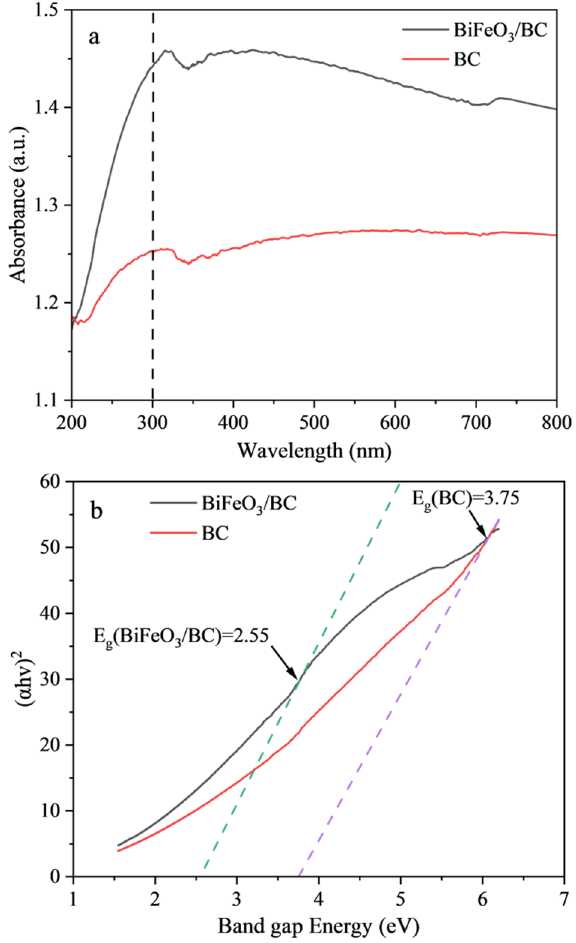
Figure 4. ( a ) UV–Vis spectra of BiFeO 3 /BC and BC; ( b ) ( α hv) 2 versus hv plot of BiFeO 3 /BC and